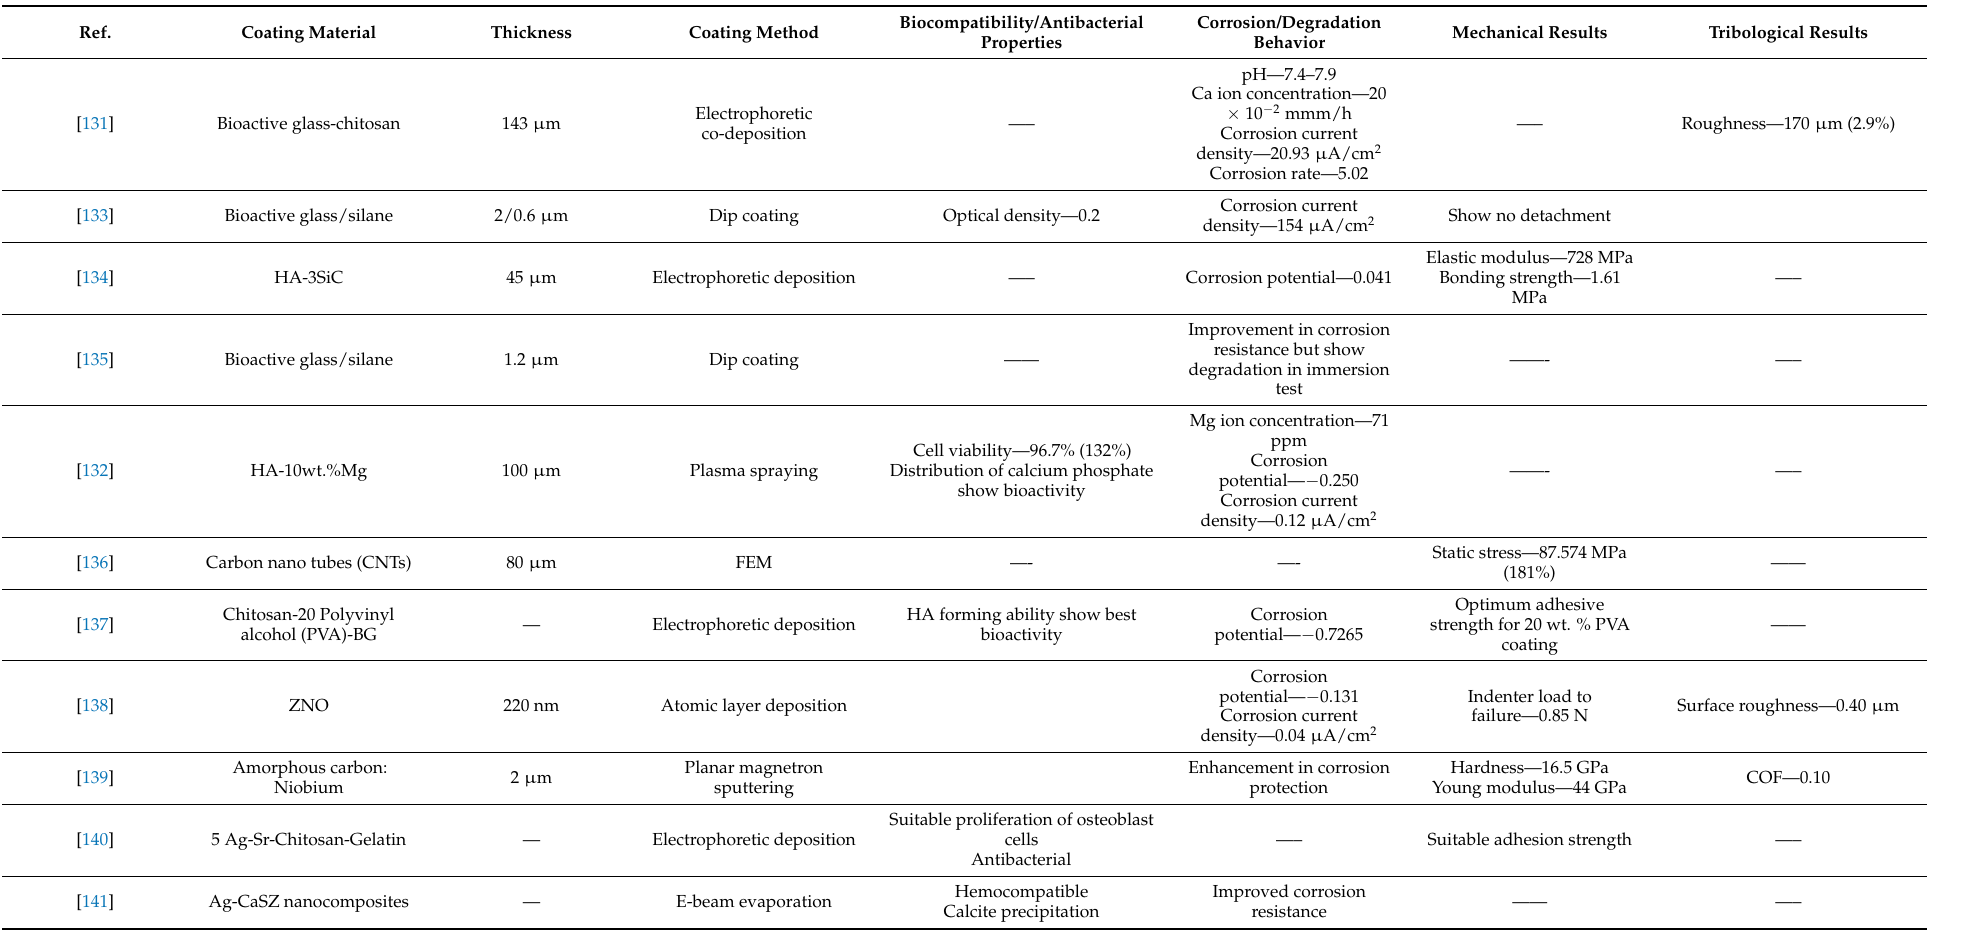
Table 4. Summary of results for stainless